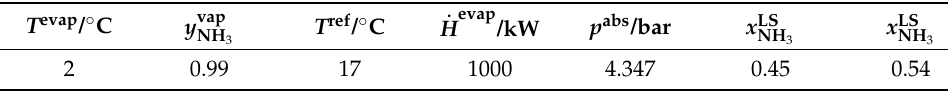
Table 2. Input data for the AC for case study 1.